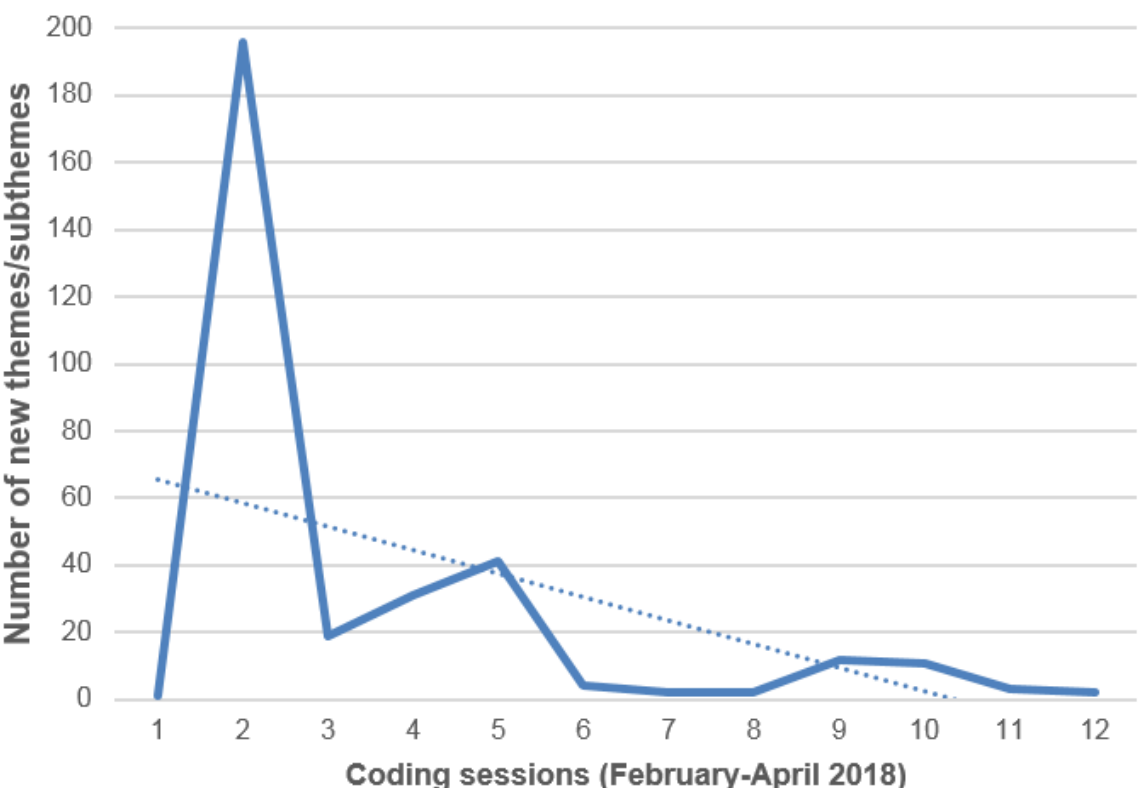
Figure 2. Qualitative data analysis: saturation of themes reached after 10 coding